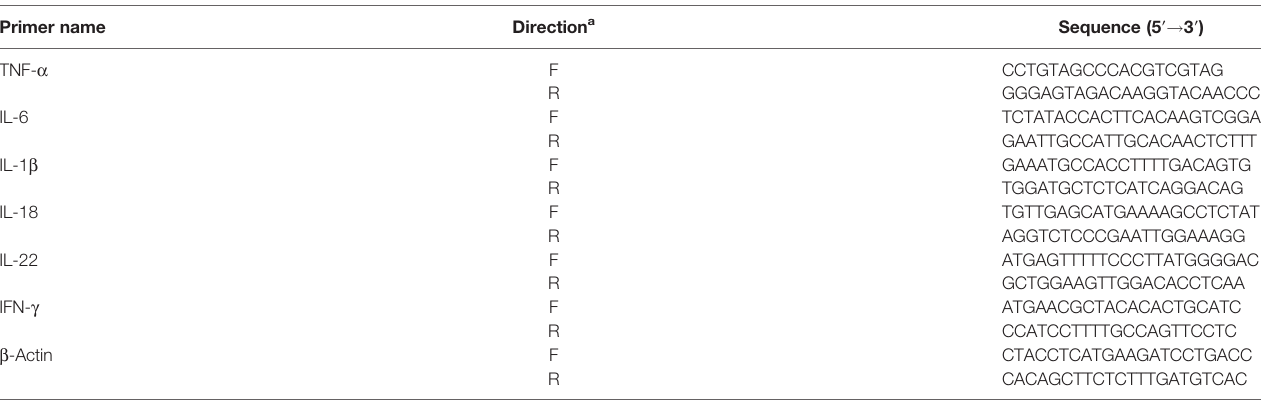
TABLE 3 | Real-time PCR